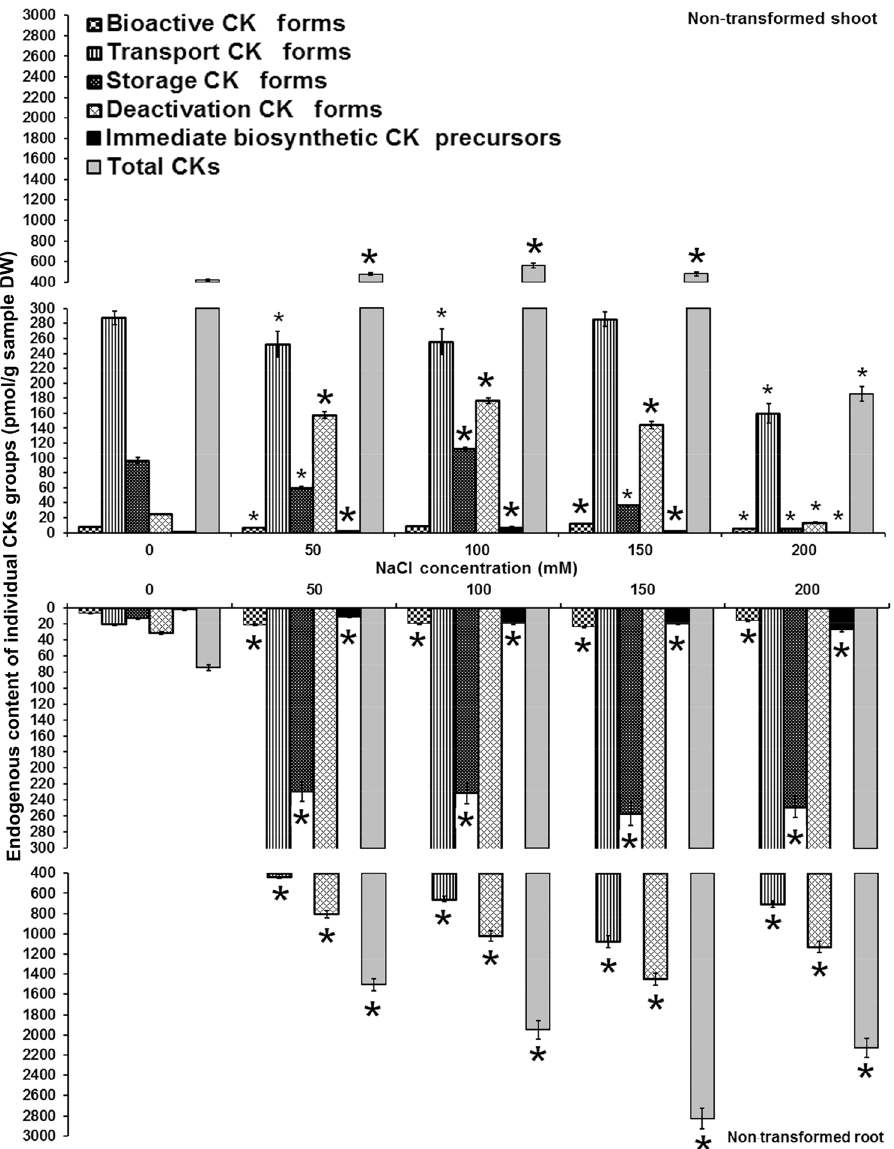
Figure 1. Endogenous cytokinin content in shoots and roots of 8-week-old non-transformed Centaurium erythraea line. According to physiological function and conjugation status cytokinins were divided into five groups including bioactive forms (DHZ, iP, tZ , c Z), transport forms (DHZ9R, iP9R, t Z9R, c Z9R), storage forms (DHZ9ROG, DHZOG, t Z9ROG, t ZOG, c Z9ROG, c ZOG), deactivation forms (DHZ7G, DHZ9G, iP7G, iP9G, t Z7G, t Z9G, c Z7G, c Z9G), immediate biosynthetic precursors ( t ZRMP, DHZRMP, c ZRMP, iPRMP) and total CKs content. Data represent mean ± standard error. Means marked with asterisks are significantly different from corresponding control values (LSD test, p ≤ 0.05). The bigger asterisks represent the values significantly higher than control ones while smaller asterisks represent values significantly lower than control